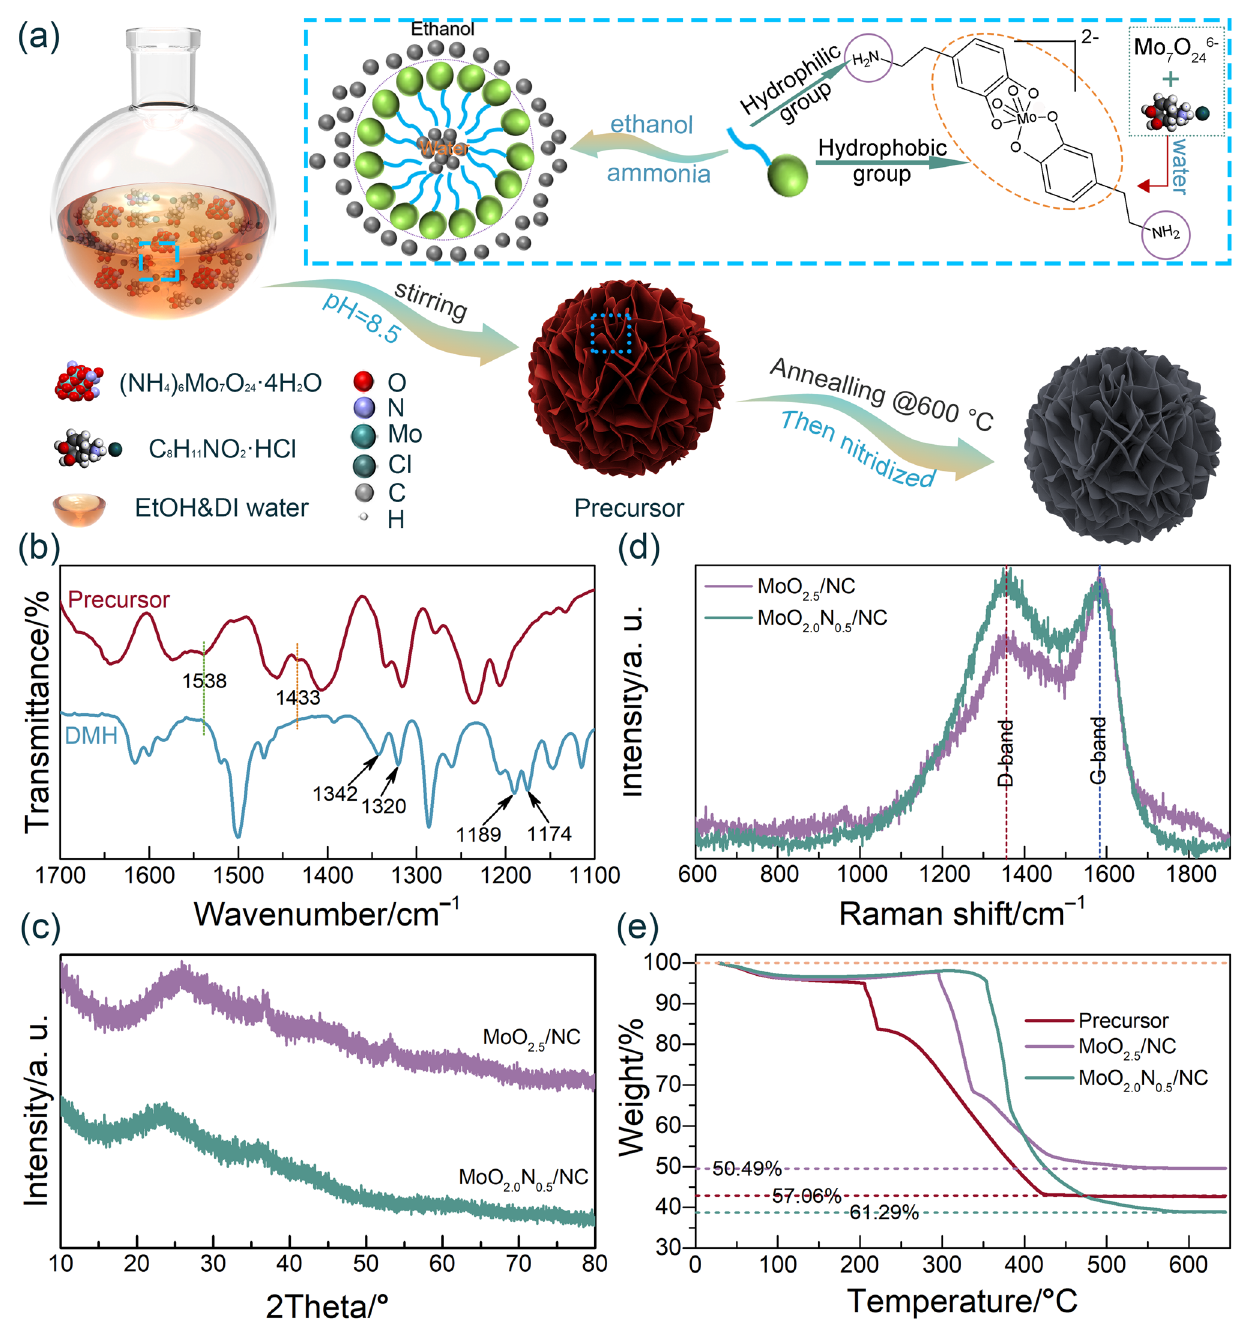
Fig. 1 a Scheme of synthesis of MoO 2.0 N 0.5 /NC hollow microspheres. b FT-IR spectra for MoO 2.5 /NC and MoO 2.0 N 0.5 /NC. c XRD patterns and d Raman spectra for MoO 2.5 /NC and MoO 2.0 N 0.5 /NC. e TGA curves for precursor (Mo-polydopamine hybrid), MoO 2.5 /NC, and MoO 2.0 N 0.5